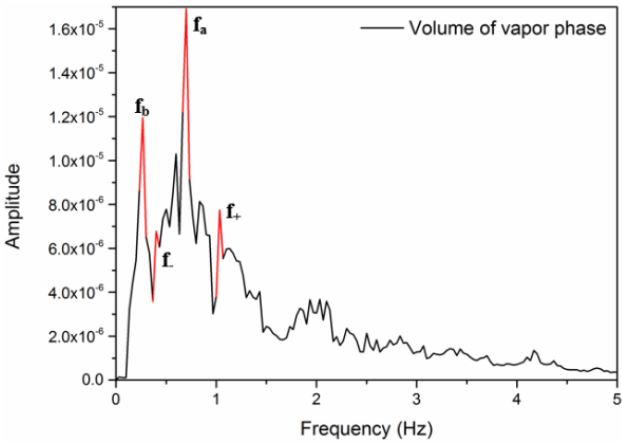
Figure 13. Marginal spectrum of vapor volume.